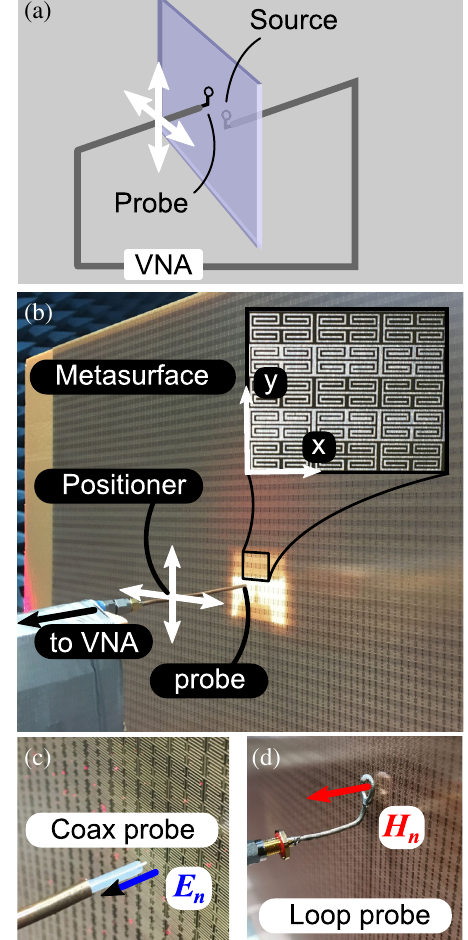
FIG. 7. (a) Scheme and (b) photo of the field measurement setup, and (c) electric and (d) magnetic field